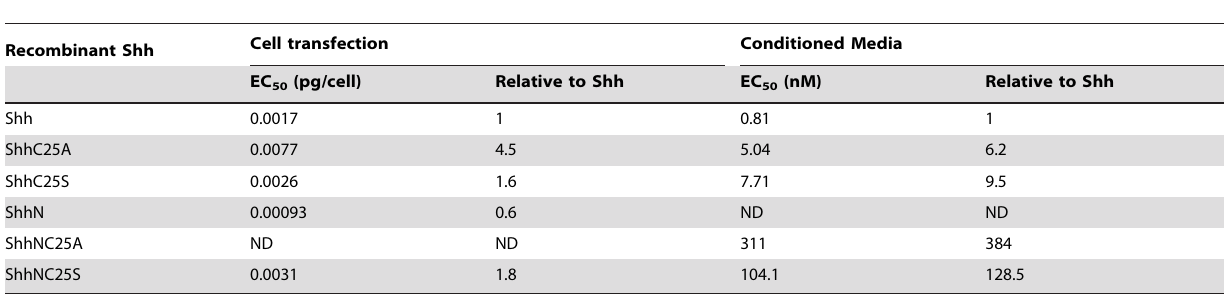
The half maximal effective concentration (EC 50 ) of Shh and recombinant variants lacking one or both lipid modifications was determined in signaling assays with NIH3T3 fibroblasts that were either transfected with recombinant Shh, or to which Shh conditioned medium was added exogenously. ND, not determined. unlabelled 5E1 antibody, permeabilized, and stained with Alexa 647-labeled 5E1 antibody (Figure S2).